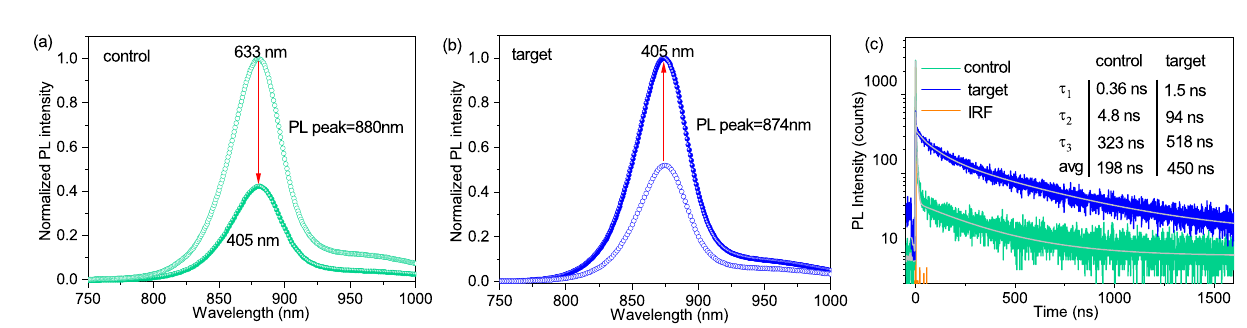
the control and target devices. The instrument response function (IRF) is also addedasareference.NotethatTRPLwasmeasuredusinga633nmexcitationlaser excited from the glass side.